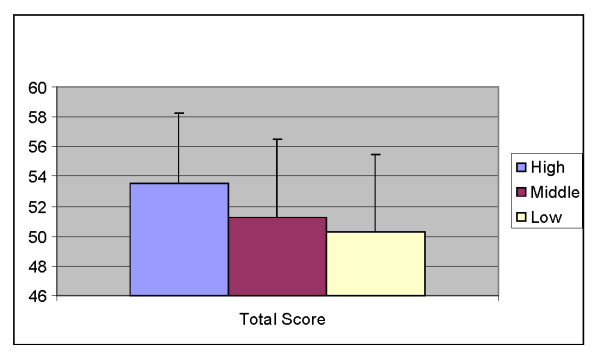
Total survey score by school.